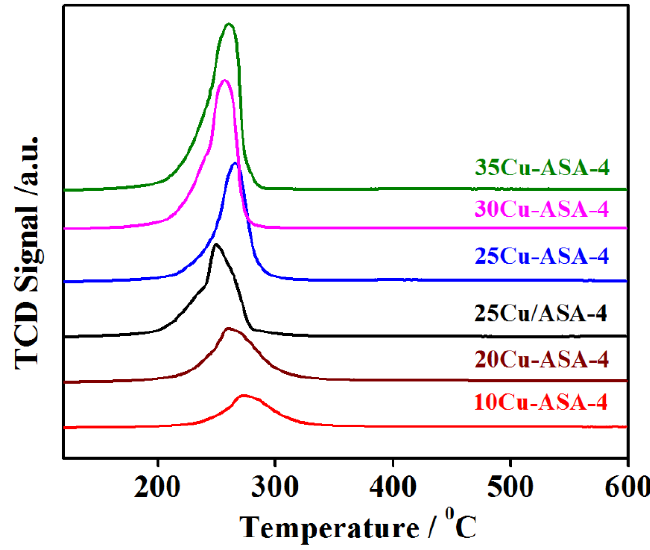
Figure 4. The H 2 -TPR profiles of the x Cu–ASA-4 and 25Cu/ASA-4 catalysts.